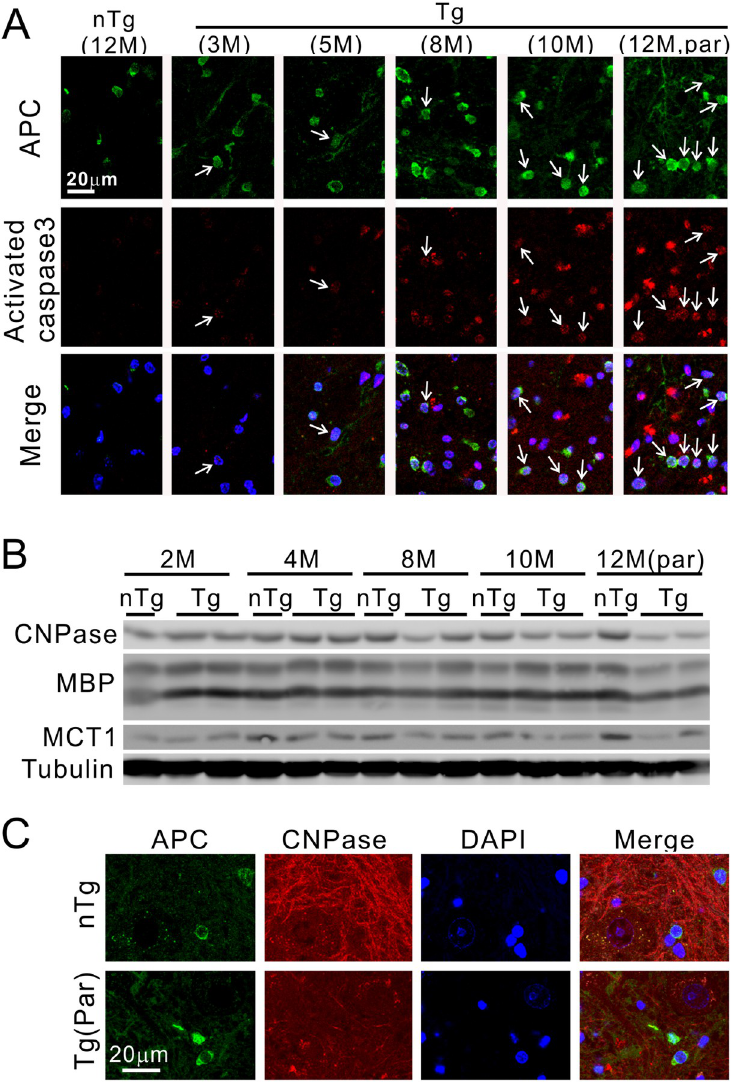
Fig 6. Oligodendrocyte pathology in TDP-43 mice. (A) Age-dependent and progressively increased activated caspase 3 signals are associated with oligodendrocytes (arrows) in the spinal cord of Tg mice. (B) Reduced myelin protein levels in the Tg mice with paralysis. M = month, CNPase = 2’,3’-cyclic-nucleotide 3’-phosphodiesterase, MBP = myelin basic protein, MCT1 = monocarboxylate transporter 1. (C) A reduced staining intensity of CNPase in the paralyzed Tg mice compared with the nTg